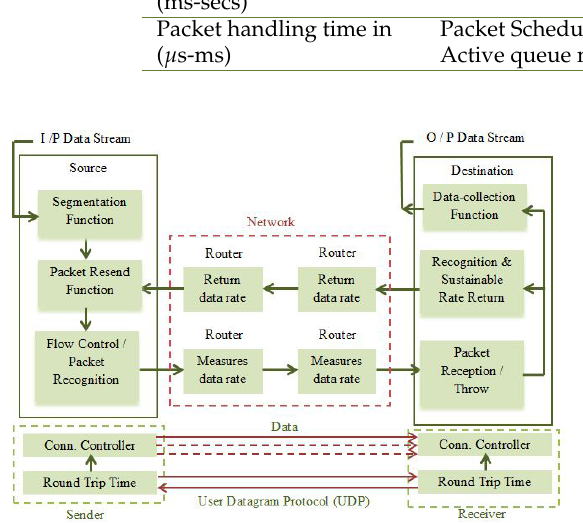
Fig. 3. The proposed overview of the Rate-based congestion control framework